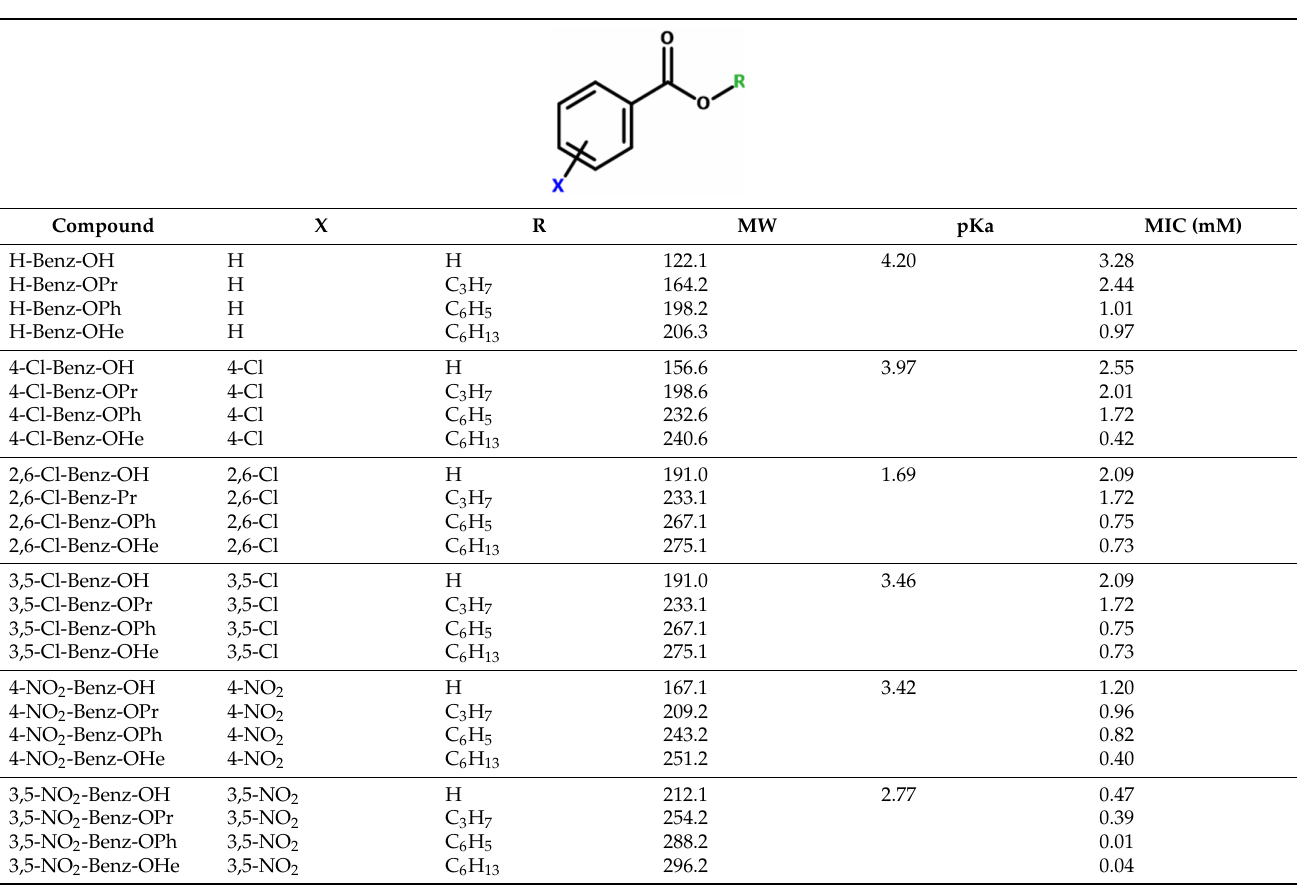
Table 1. Structure of the compounds under study, MW, pKa of the free acid, and MIC against M. tuberculosis . The ionization constants (pKa) were predicted using ACD/pKa (ACD/Labs, version 12; Advanced Chemistry Development: Toronto, Canada) and are in accordance with that described in their pKa data base (ACD/pKa DB)”.